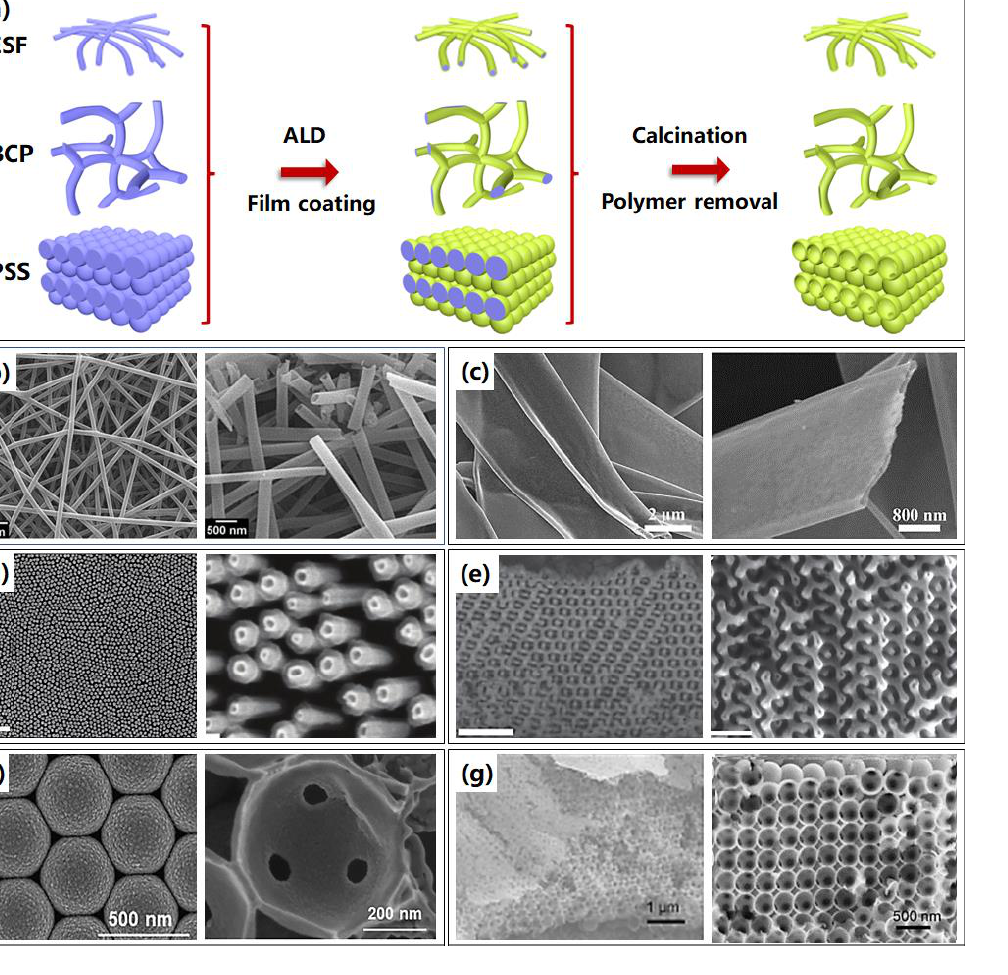
Figure 9. Typical assembled polymer templates are combined with ALA method to fabricate 3D nanostructures. ( a ) The illustrated process routines of 3D nanostructures based on assembled poly-